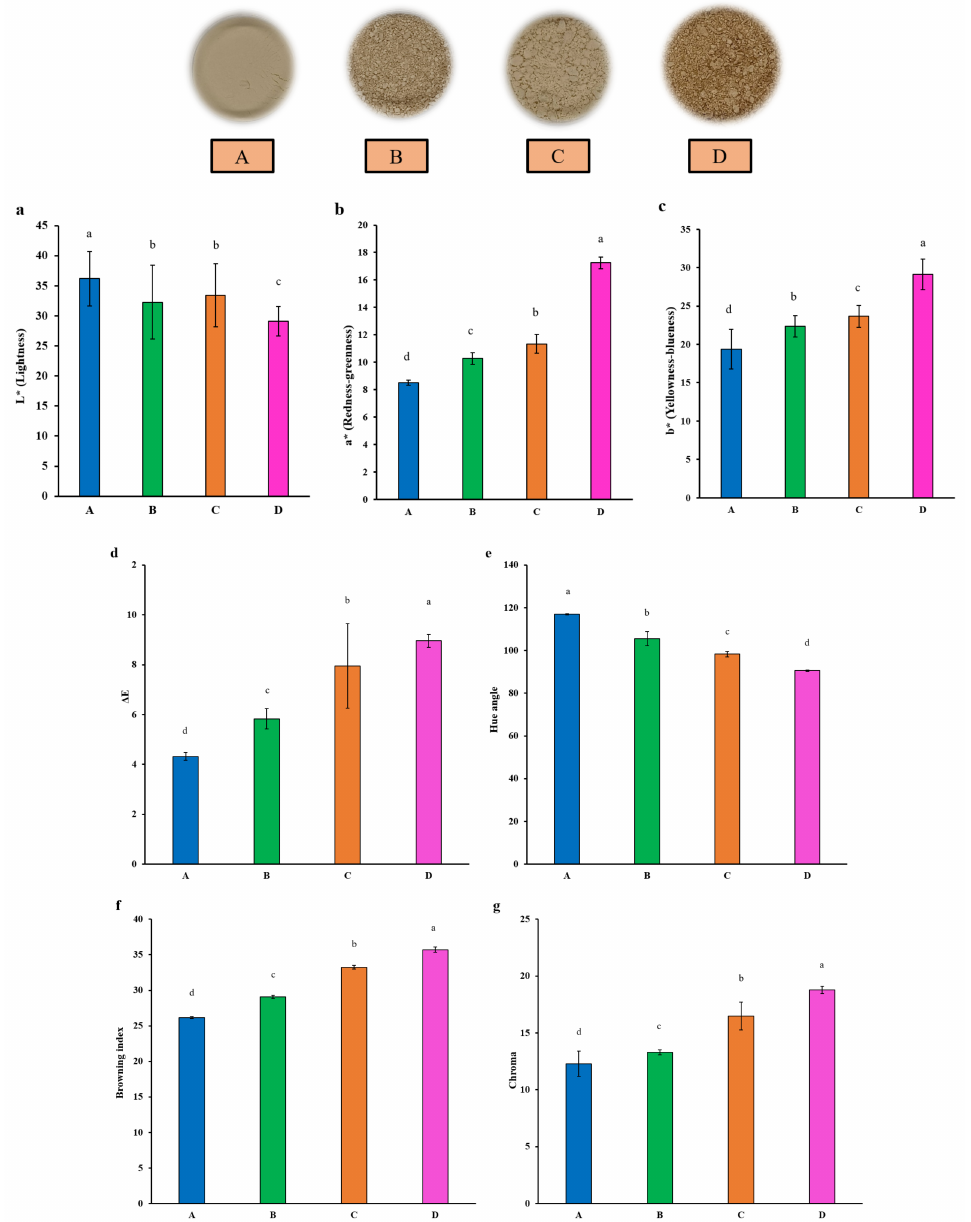
Figure 2. Appearance of the rice protein, and the ( a ) color in terms of L * , ( b ) a * , ( c ) b * value; ( d ) total color difference ( ∆ E); ( e ) hue angles; ( f ) browning index; and ( g ) chroma. Lowercase letters in the same column indicate significant differences according to Duncan’s multiple range tests ( p <